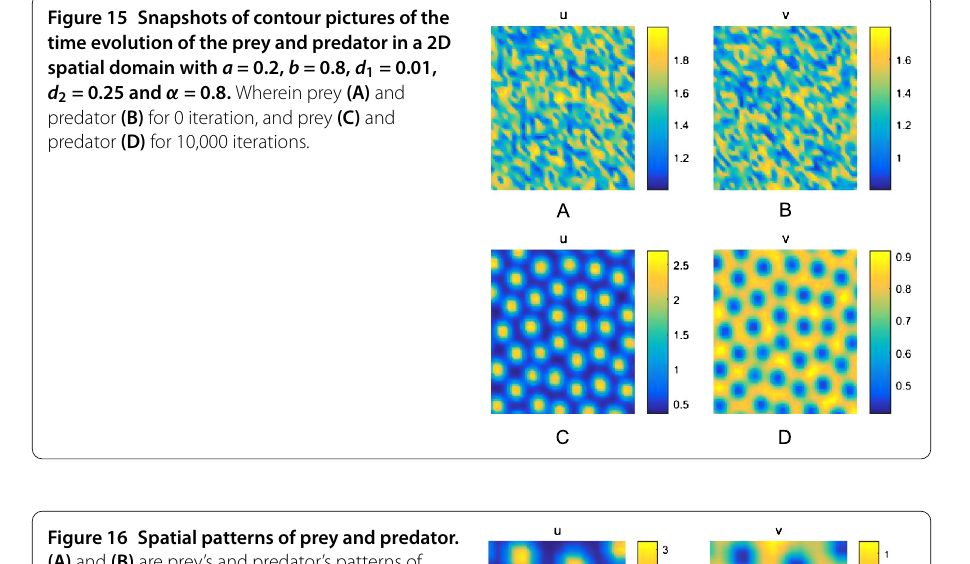
Figure 16 Spatial patterns of prey and predator. (A) and (B) are prey’s and predator’s patterns of system (1.3a)-(1.3d), but (C) and (D) are their patterns of the corresponding first-order system